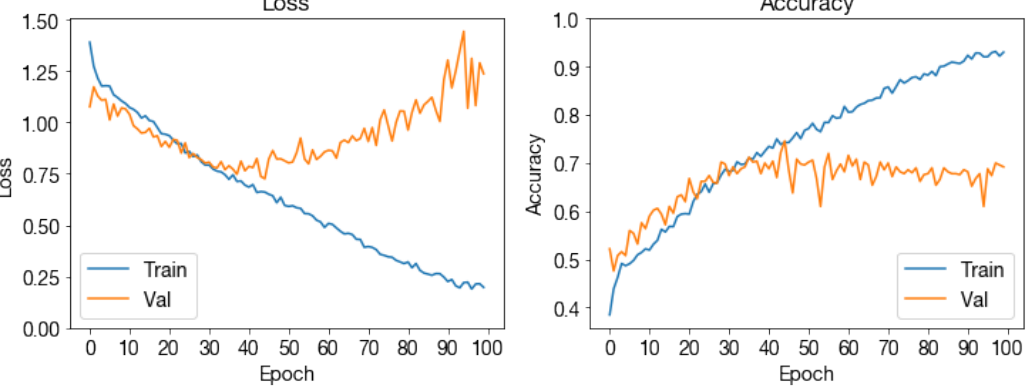
Figure A5. Pretrained ResNet-18 loss and accuracy across training